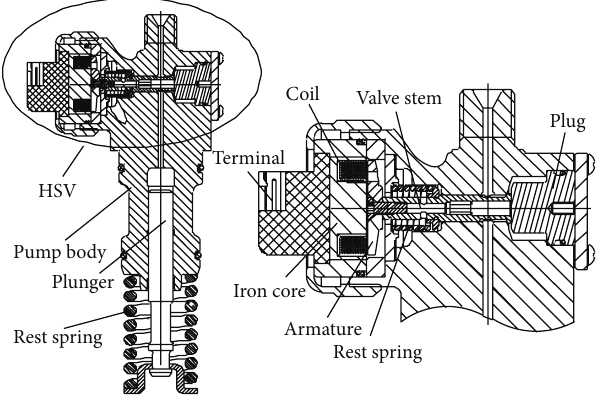
Figure 1: Schematic of EUP and HSV.